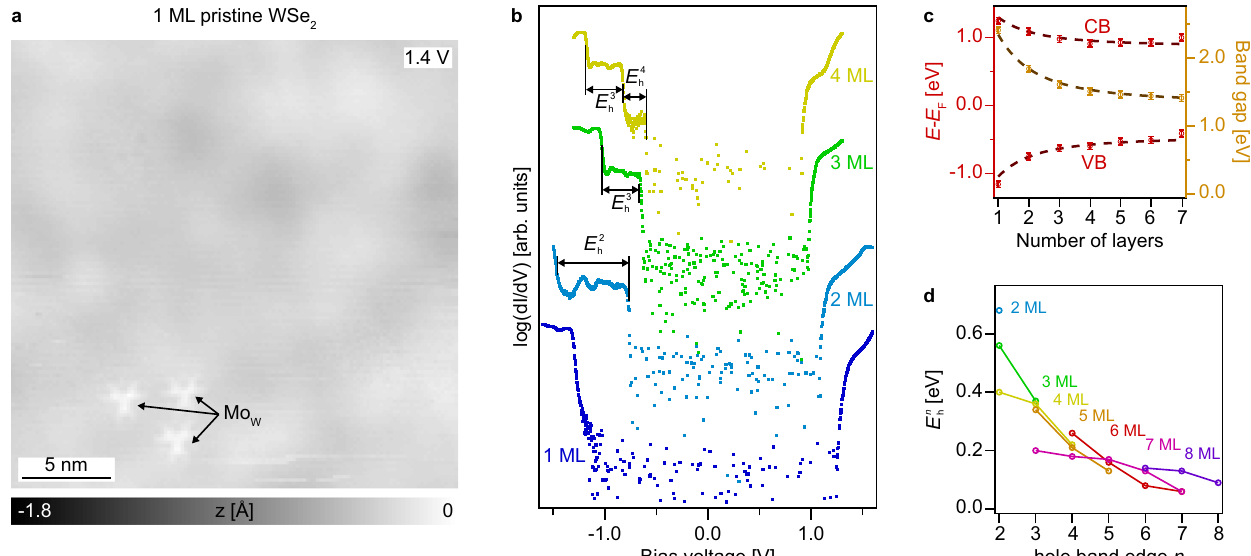
Fig. 2 Layer-dependent electronic properties of undoped WSe 2 . a STM image of undoped monolayer WSe 2 at V B = 1.4 V. b Layer dependent STS signal of undoped WSe 2 . c The experimentally determined conduction band edge, valence band edge, and band gap of undoped WSe 2 as a function of layer count (markers). The experimental data in ( c ) is fi tted with the tight binding model presented in the text (dashed lines). d The energy of each plateau identi fi ed in the STS of undoped WSe 2 plotted versus the corresponding number of hole band edge n in the quantum well model.